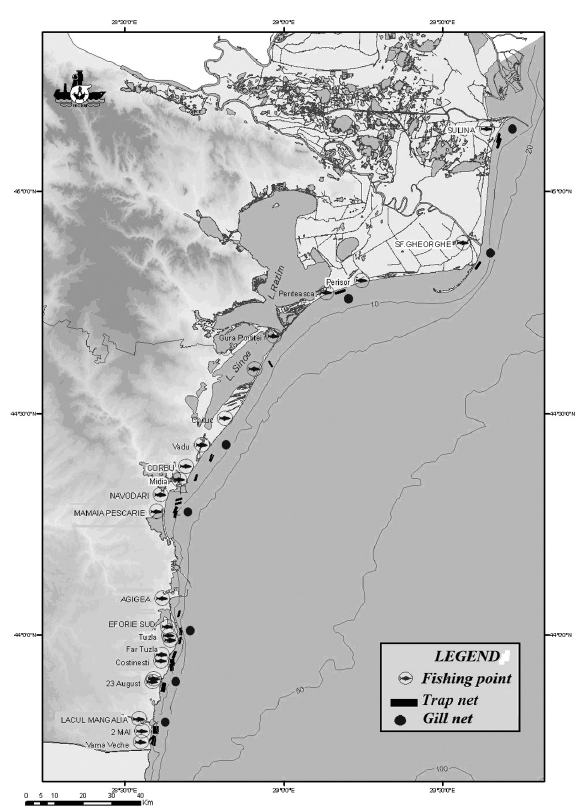
Fig. 2. – Fisheries points along the Romanian